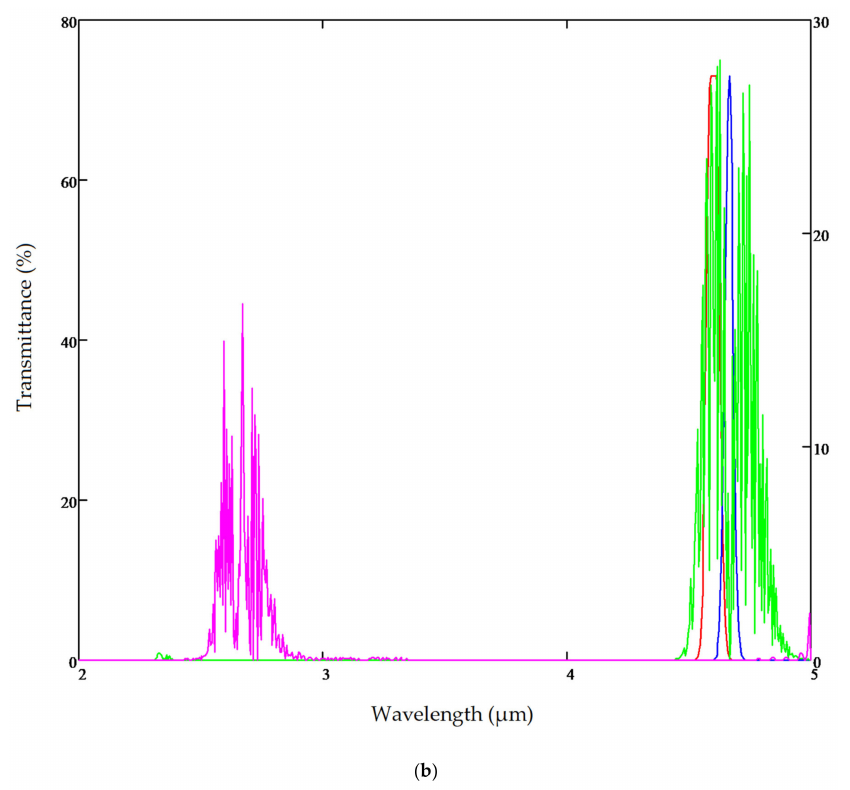
Figure 16. ( a ) Design A: CO filter transmission using 480 nm wide commercially available signal [37] and reference filters. ( b ) CO filter transmission using 100 nm wide in-house designed signal filter and reference filters [33].